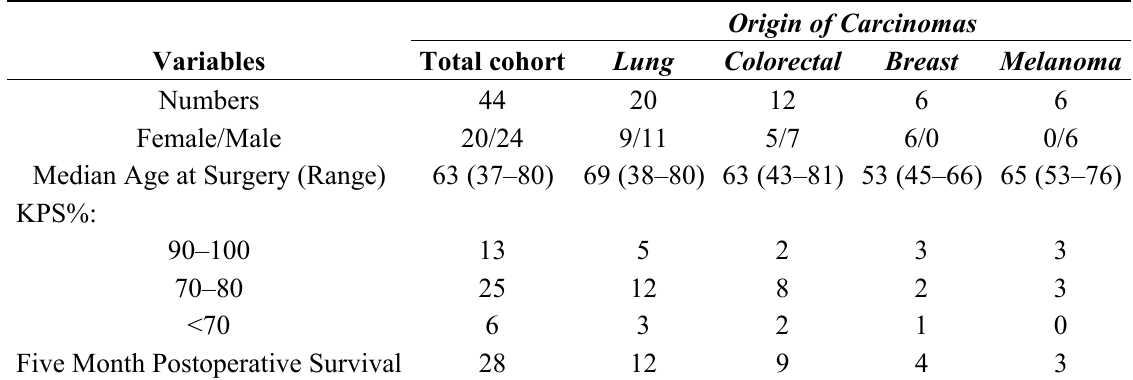
Table 1. Patient and sample characteristics ( n = 44).